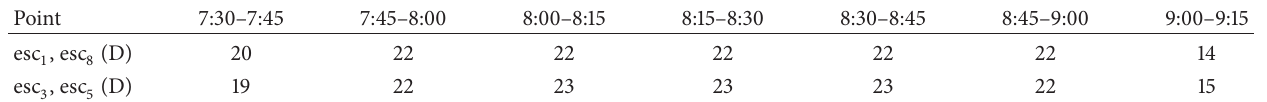
Table 4: Waiting time in different time interval during peak hours.